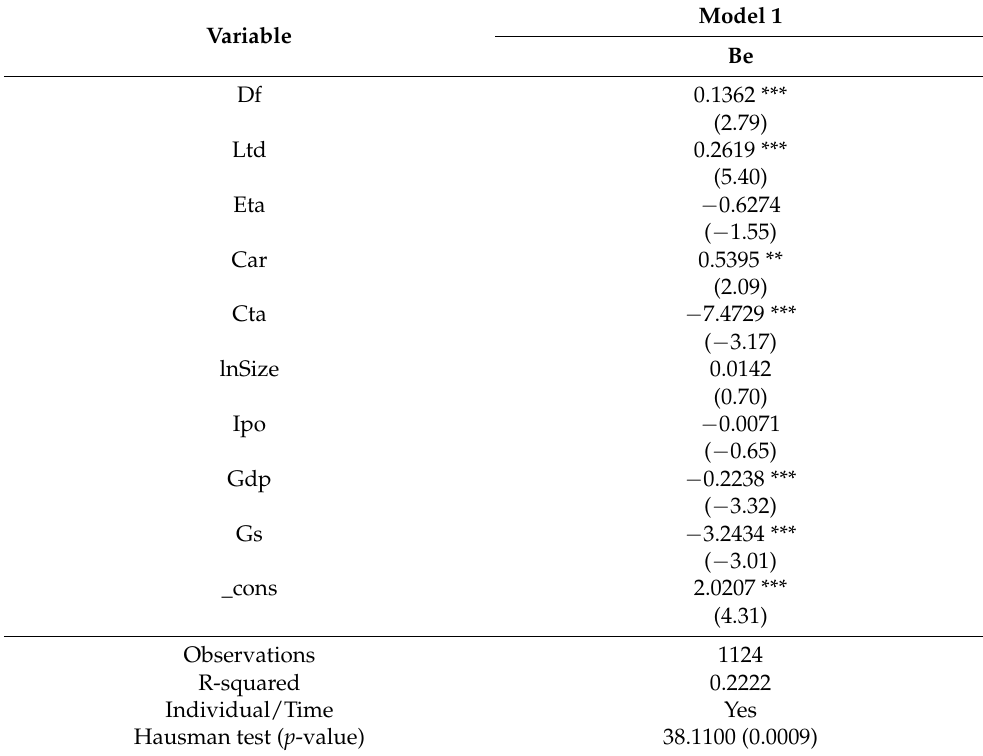
Table 5. Regression